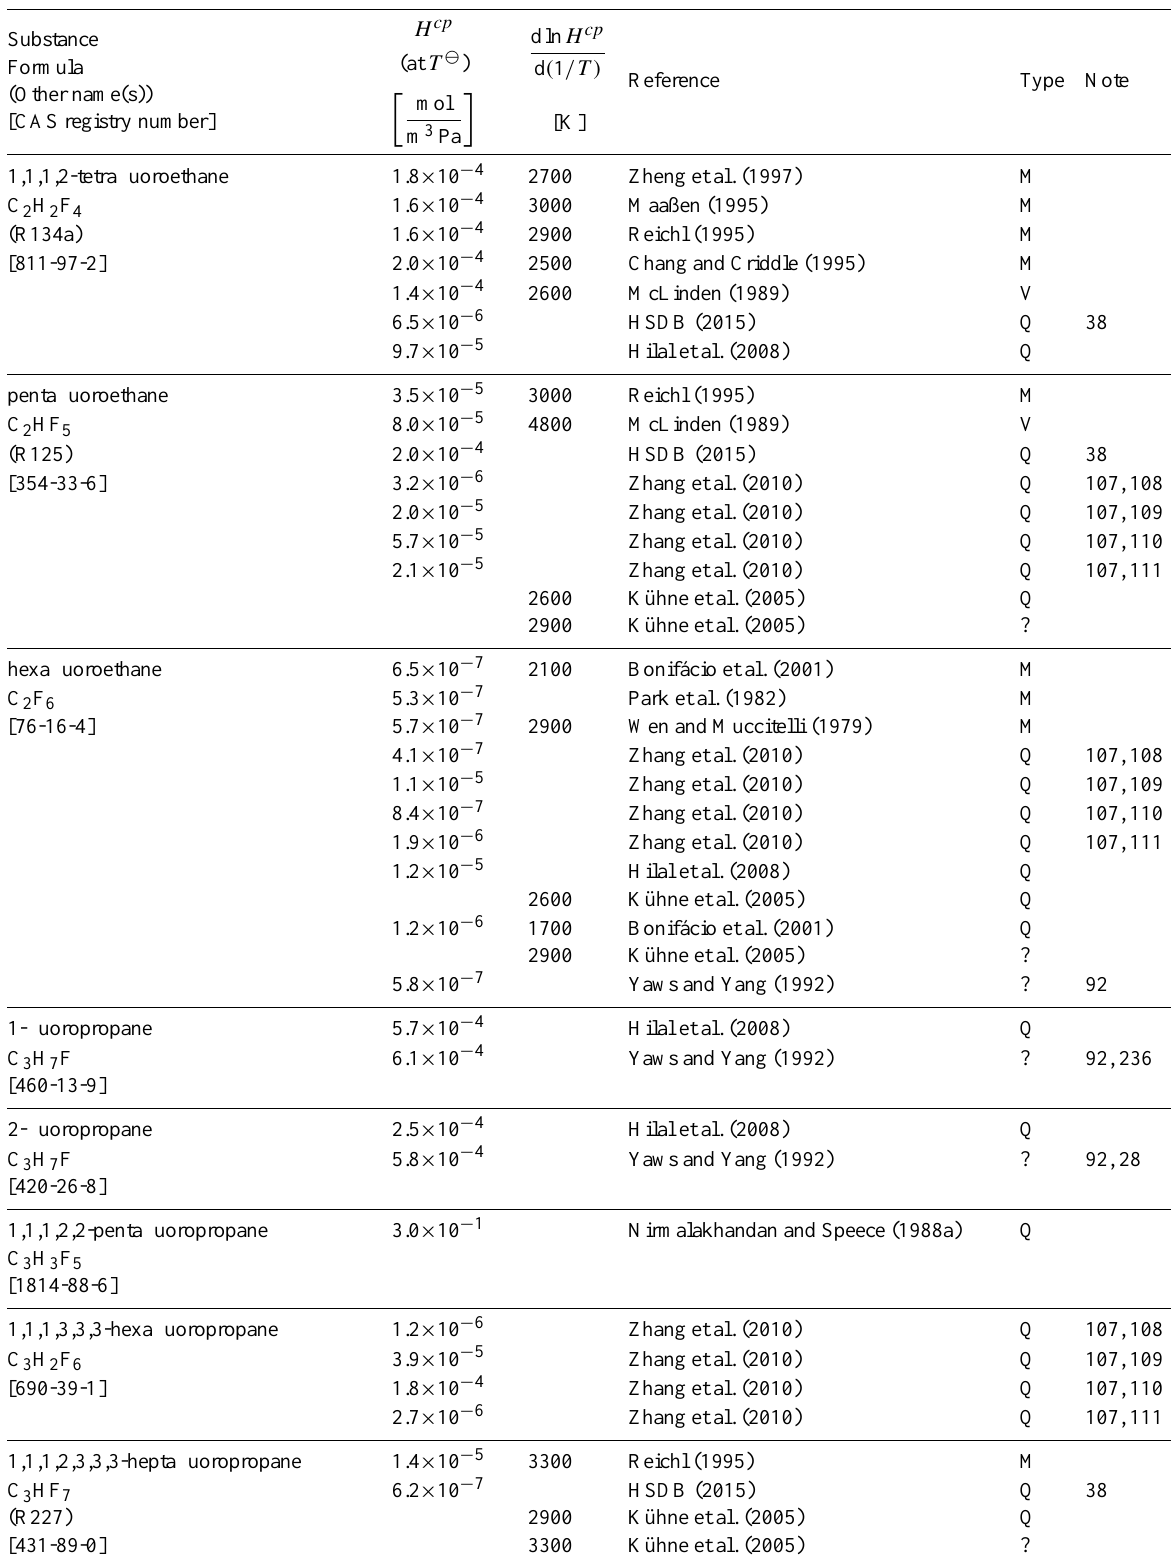
Table 6: Henry’s law constants for water as solvent